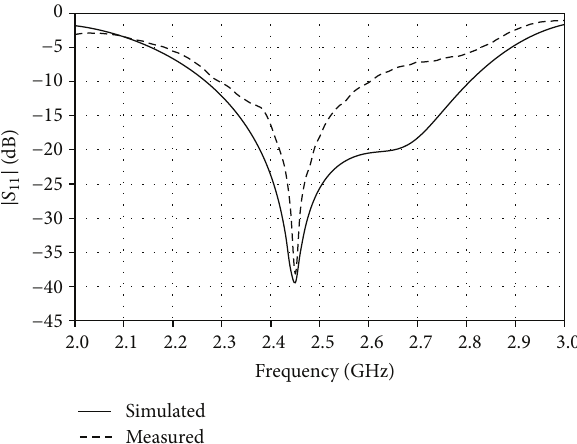
Figure 22: The simulated and measured |𝑆 11 | of the waveguide-dependent triple-aperture antenna.